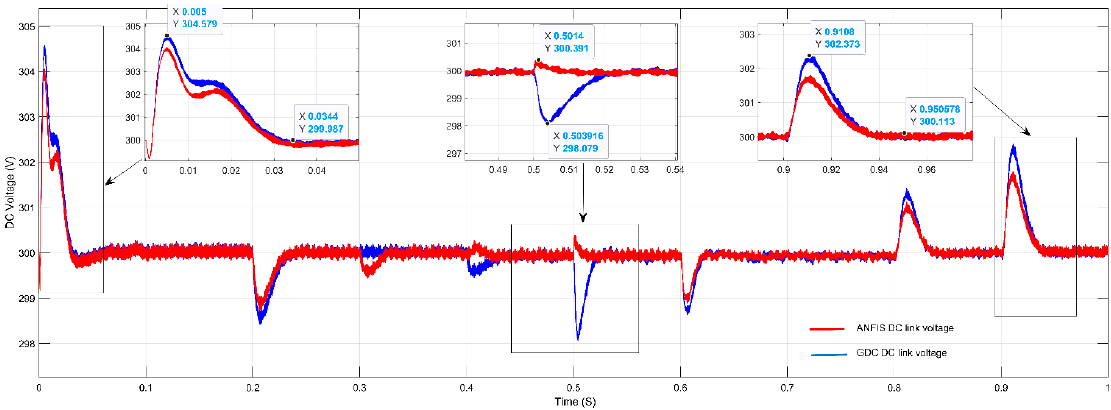
Figure 17. Comparison of DC link voltage.